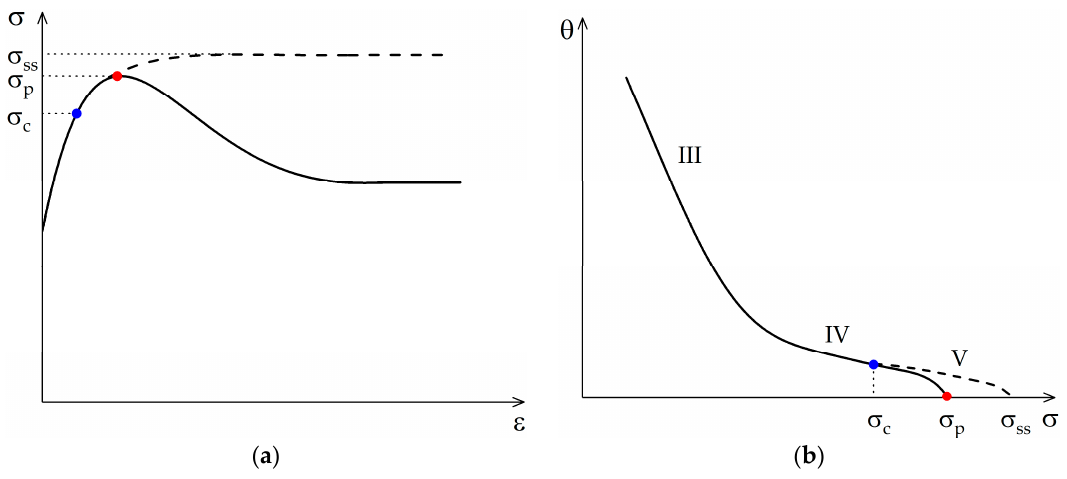
Figure 2. In ( a ) it is shown schematically the evolution of flow stress with (true) strain in the case of a single peak due to dynamic recrystallization (DRX). The dashed line displays the theoretical case of a solely dynamically recovering microstructure, i.e., DRV whereas the solid line includes DRX effects. Sub-figure ( b ) details the corresponding strain-hardening rate evolution in Poliak Jonas space which shows an inflection point (blue dot) and peak stress point (red dot).